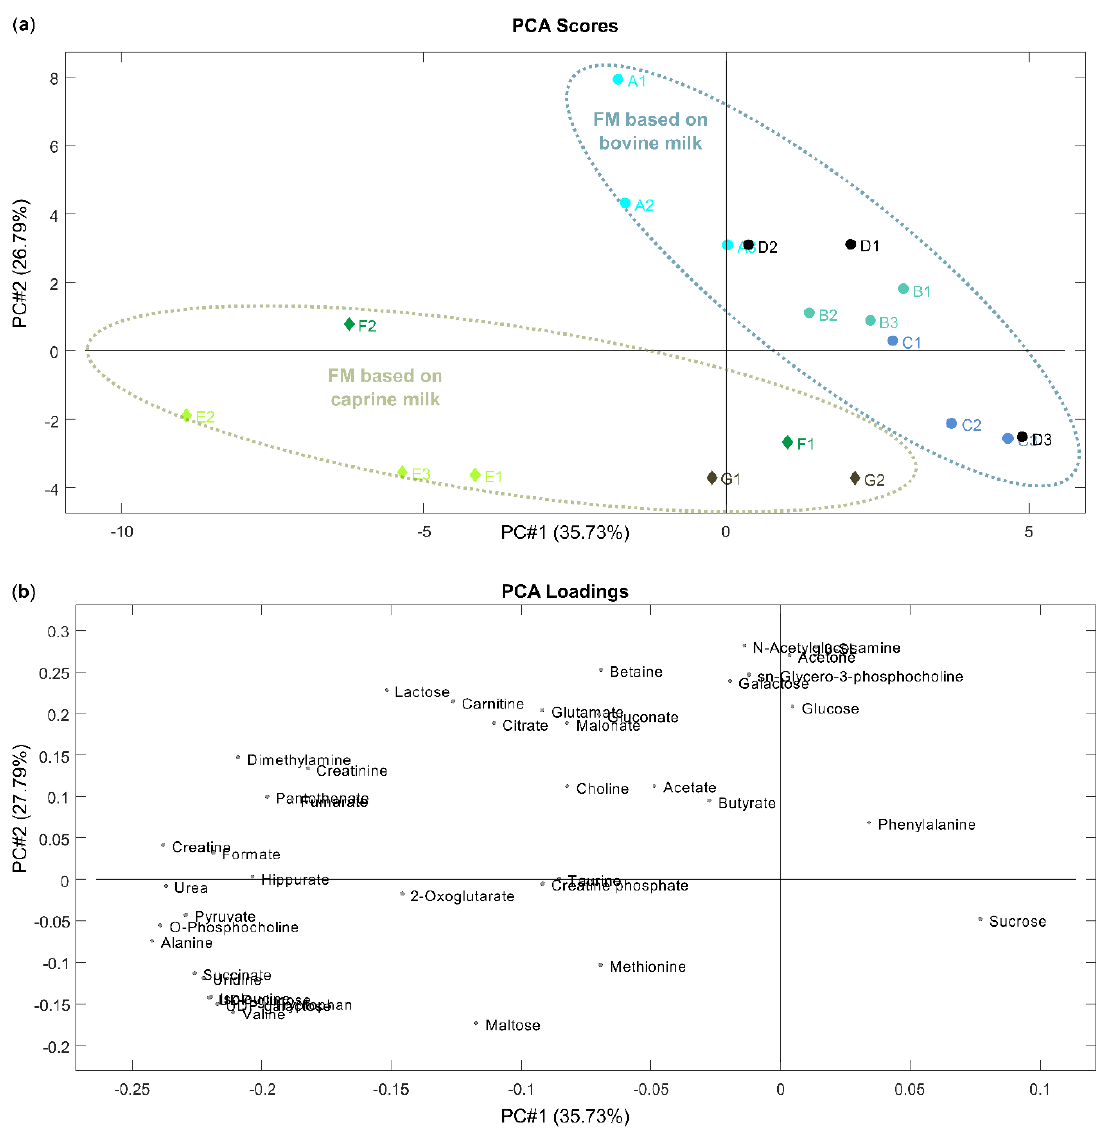
Figure 4. PCA of FM samples. (a) Score plot, samples colored for brands (see Table S2); and (b) loading plot.